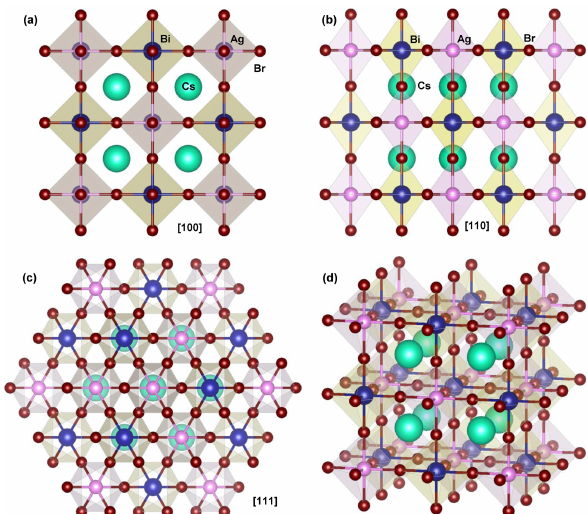
Figure 23: Structural models of Cs 2 AgBiBr 6 with double perovskite structures, observed along (a) [100], (b) [110], and (c) [111]. (d) Perspective view of the structure.